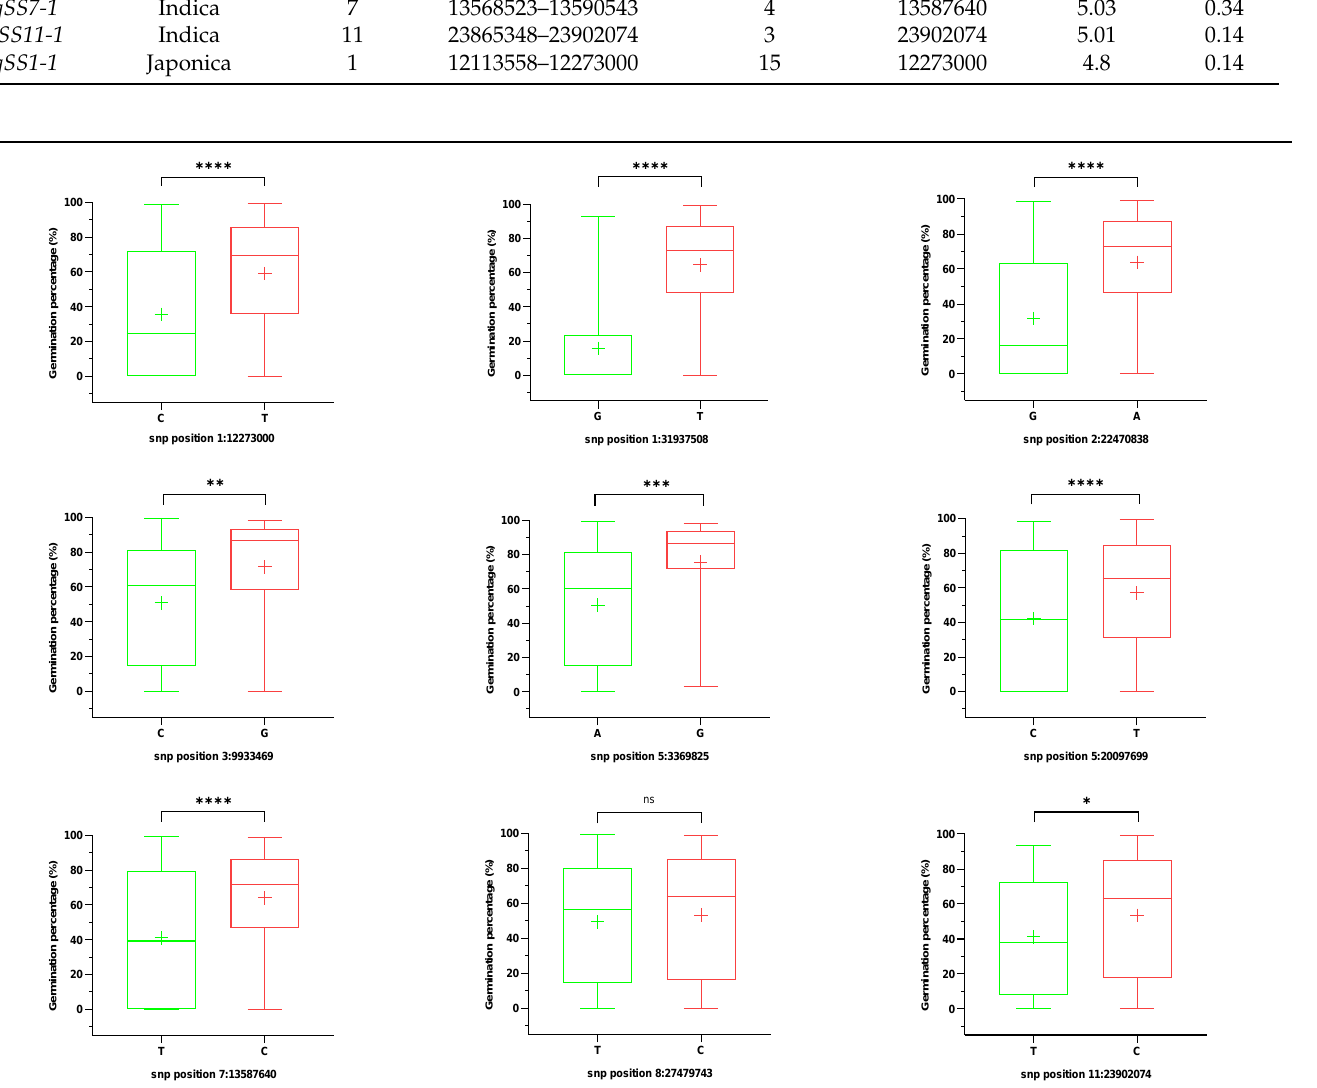
Figure 4. The box plots showing the phenotypic distribution at the nine superior and inferior alleles of lead SNPs in the world core collection. The plus shows the mean; the middle line shows the median, and the box shows the range of the 25th to 75th percentiles of the total data and the whiskers show the interquartile range and the outliers. ns, *, **, *** and **** denote significant differences in mean phenotypic between superior and inferior alleles at p > 0.05, p < 0.05, 0.01, 0.001, and 0.0001, respectively. Table 2. The lead SNP effect value in the whole population, indica subspecies, and japonica subspecies, respectively. Chr.